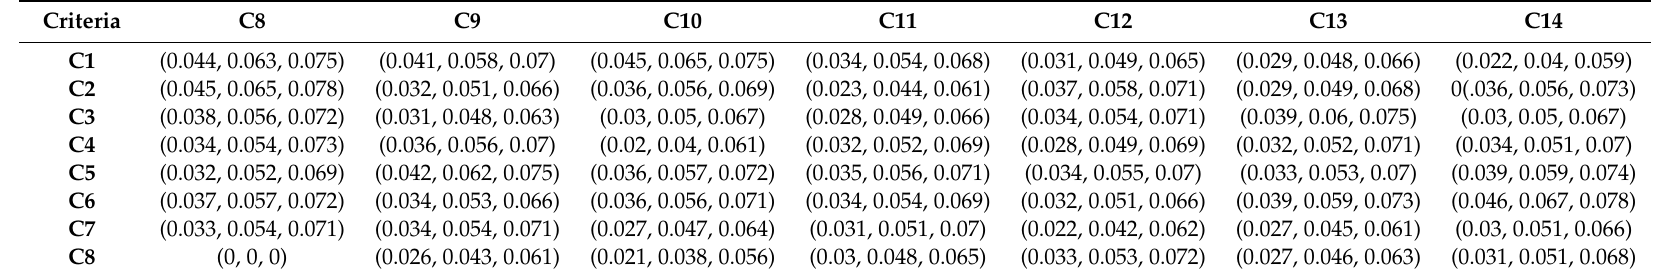
Table 3. The initial direct-relations fuzzy matrix of expert 8 to